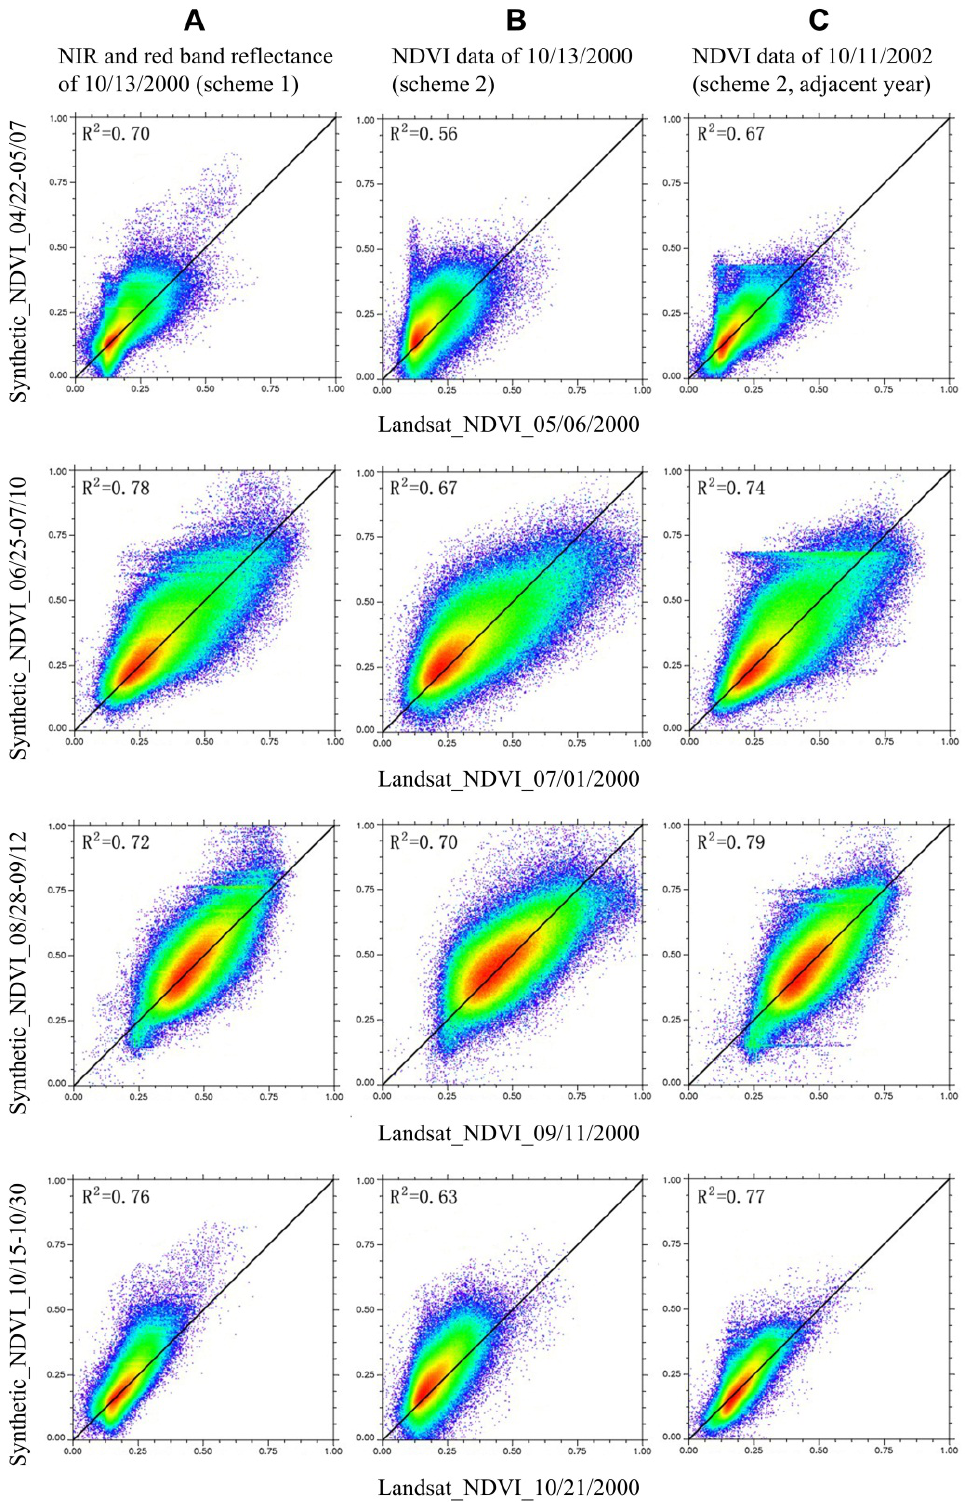
Figure 4. Per-pixel comparison between Landsat NDVI of 6 May 2000, 1 July 2000, 11 September 2000 and 21 October 2000 and the corresponding synthetic NDVI generated from STARFM with base pair images of ( A ) NIR and red band reflectance of 13 October 2000 (scheme 1), ( B ) NDVI data of 13 October 2000 (scheme 2) and ( C ) NDVI data of 11 October 2002 (scheme 2, adjacent year). The times of the synthetic NDVI were the MODIS composite